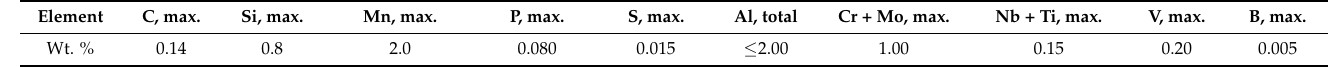
Table 1. Chemical composition of the steel HCT500X (1.0939) according to DIN EN 10346:2009 [26]. Element